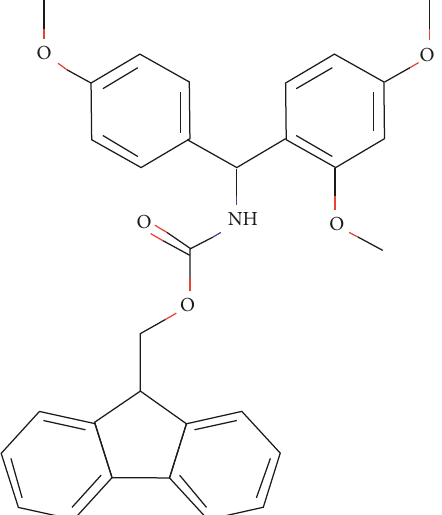
Figure 2: Chemical structure of the rink-amide resin used in the SPPS